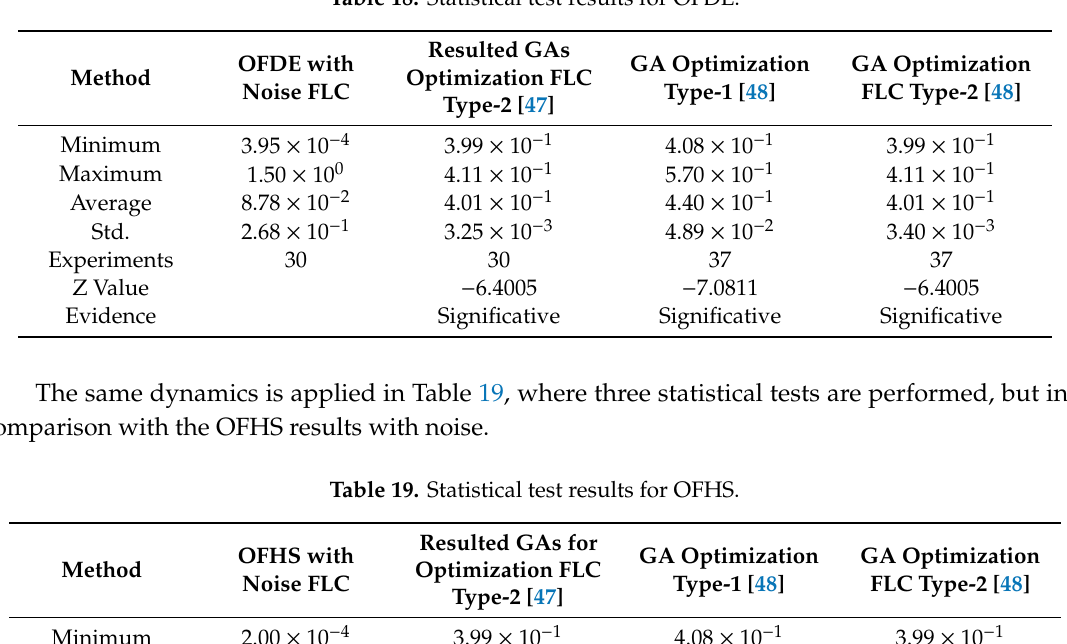
Table 18. Statistical test results for OFDE.